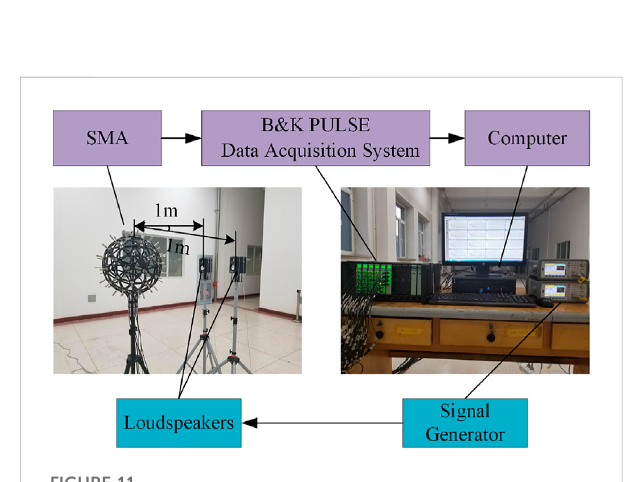
FIGURE 11 Experimental setup.The blue background text at the bottom of the fi gure represents an experimental signal transmission system consisting of a signal generator and loudspeakers. The purple background text at the top of the fi gure represents an experimental receiving system consisting of an SMA, data acquisition system, and